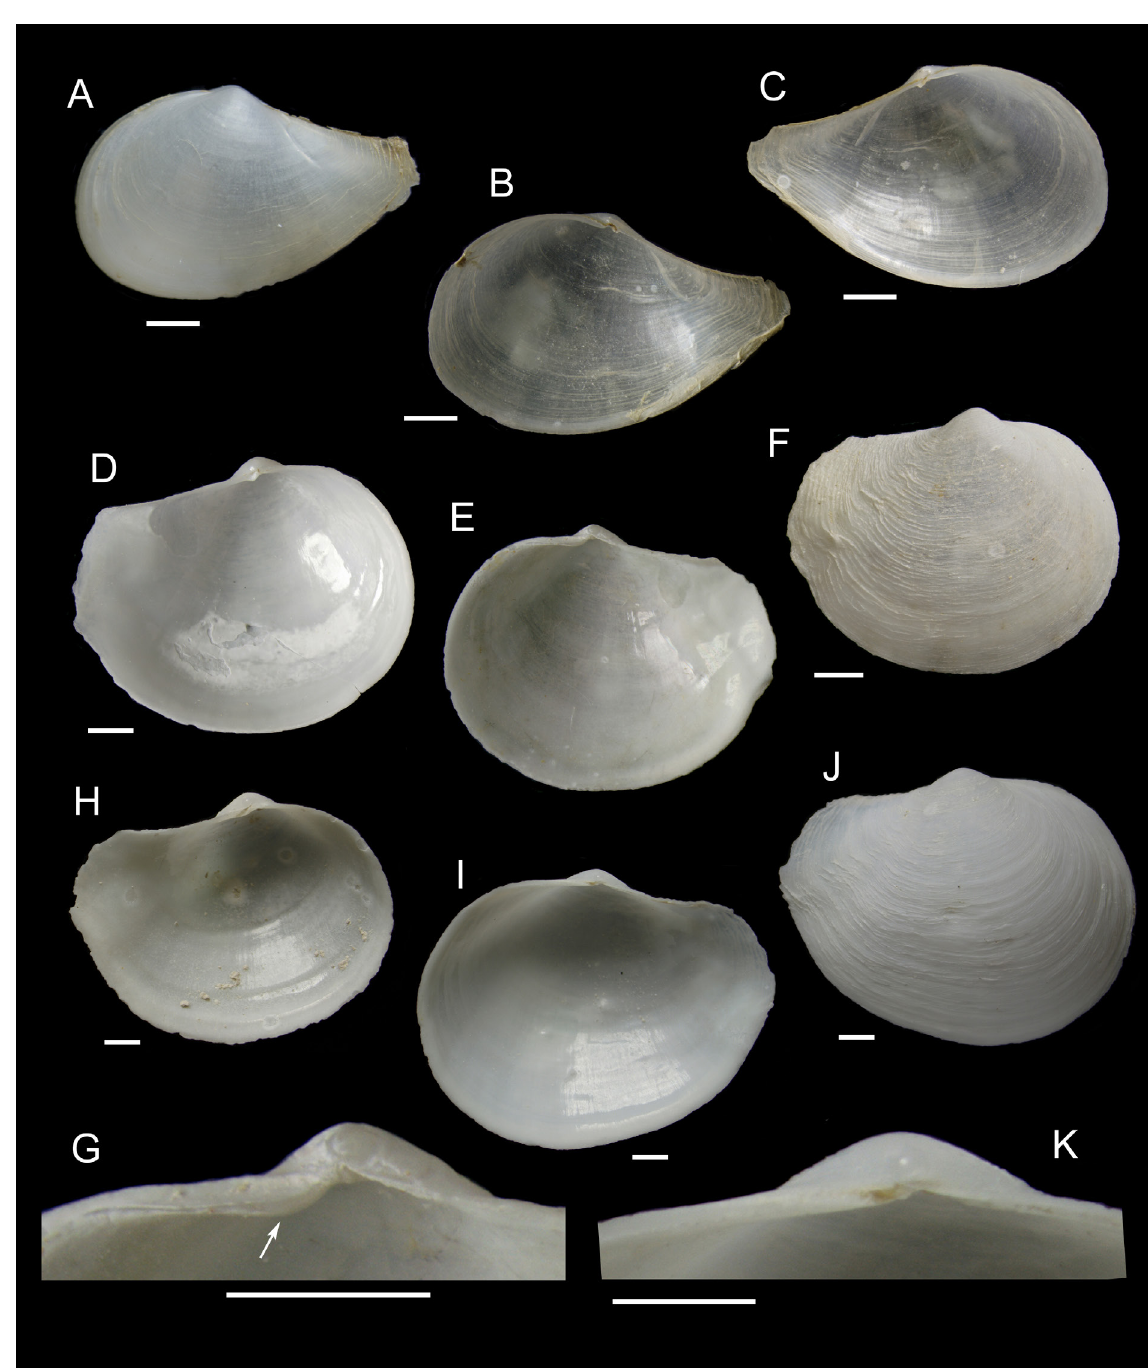
Fig. 43. Halonymphidae, Protocuspidariidae. A–C . Halonympha depressa (Jeffreys, 1882), BANGAL 0711, V2, 1706 m, 6.5 and 6.8 mm. D–F . Protocuspidaria verityi Allen & Morgan, 1981, BANGAL 0711, V2, 7.3 and 6.4 mm. G. Detail of the hinge of the right valve (same as E), the arrow points to the diagnostic anterior tooth. H–J . Protocuspidaria simplis Allen & Morgan, 1981, BANGAL 0711, V10, 1720 m, 9.0 mm, 10.1 mm. K . Detail of the hinge of the right valve (same as I), without tooth. Scale bars = 1